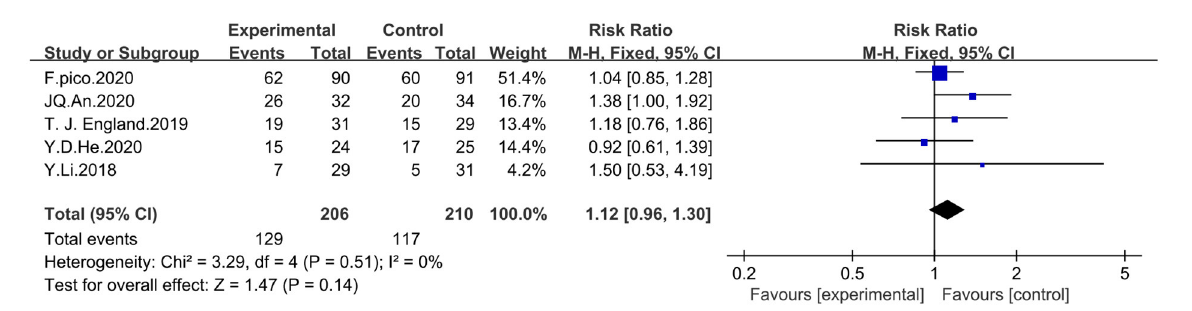
FIGURE5 Forest plot showing effect of RIPostC on the rate of good prognosis.